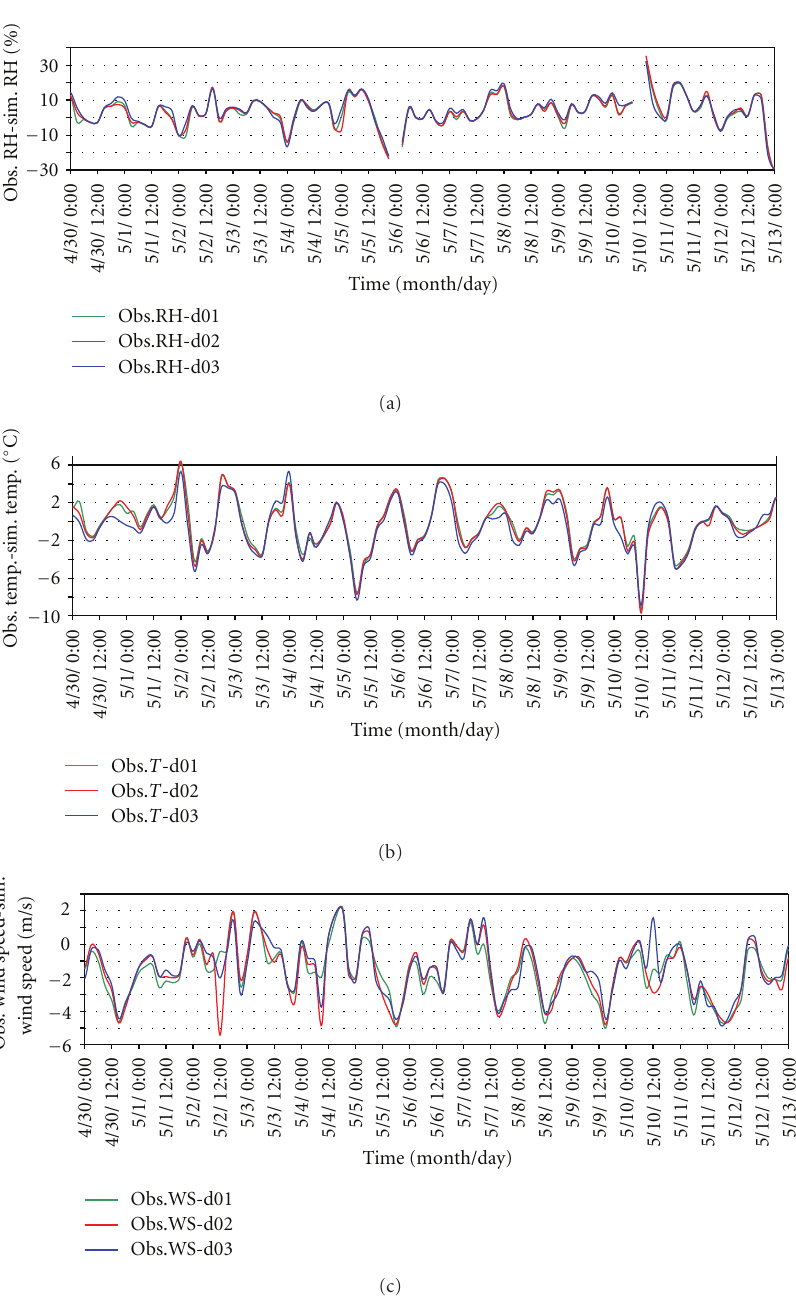
Figure 6: Comparison of di ff erence between observed and estimated (at di ff erent domain resolutions) temperature, wind speed and direction, and relative humidity for station